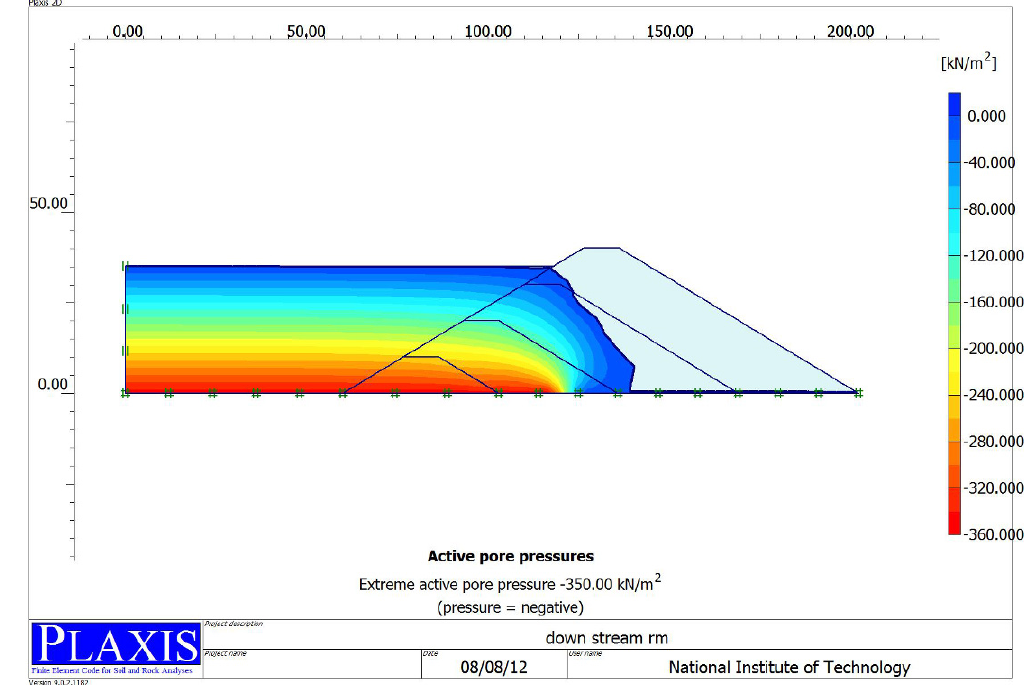
Figure 18. Cross section of downstream method dam with phreatic line and pore pressure